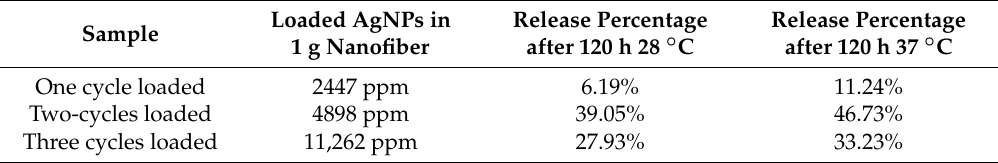
Figure 6. The amount AgNPs loaded (ppm) in one gram PAN nanofibers: ( A ), the release profile of PAN/AgNPs nanofibers at 28 °C: ( B ), and release profile of PAN/AgNPs nanofibers at 37 °C: ( C ). Table 2. The release profile of PAN nanofibers containing AgNPs with different cycles.